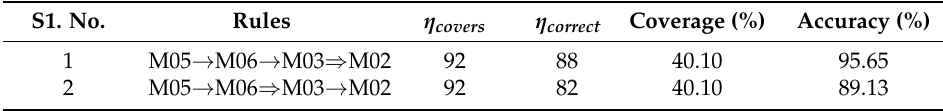
Table 8. The result of the classification.